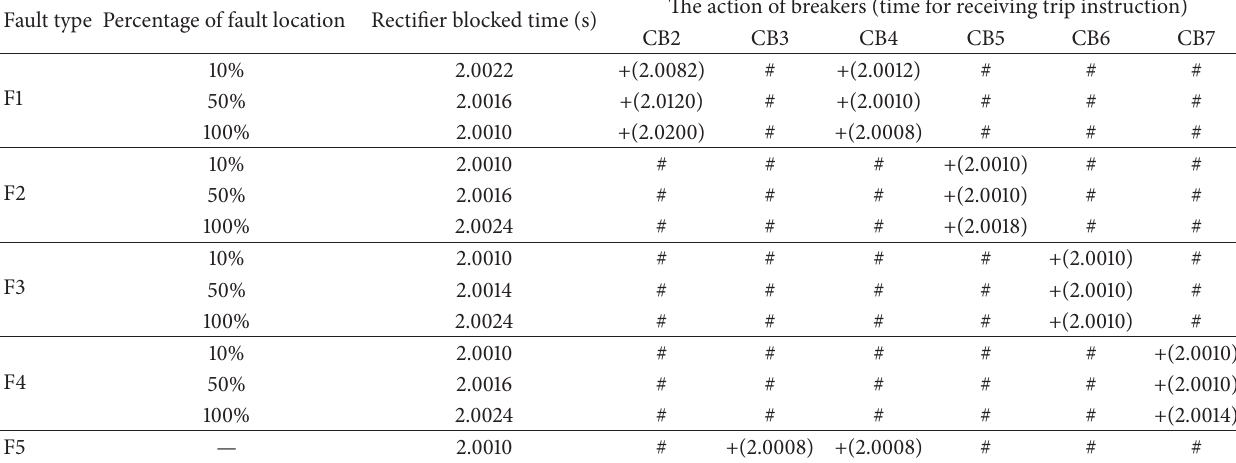
Table 3: The action situation of each CB during F1–F5.